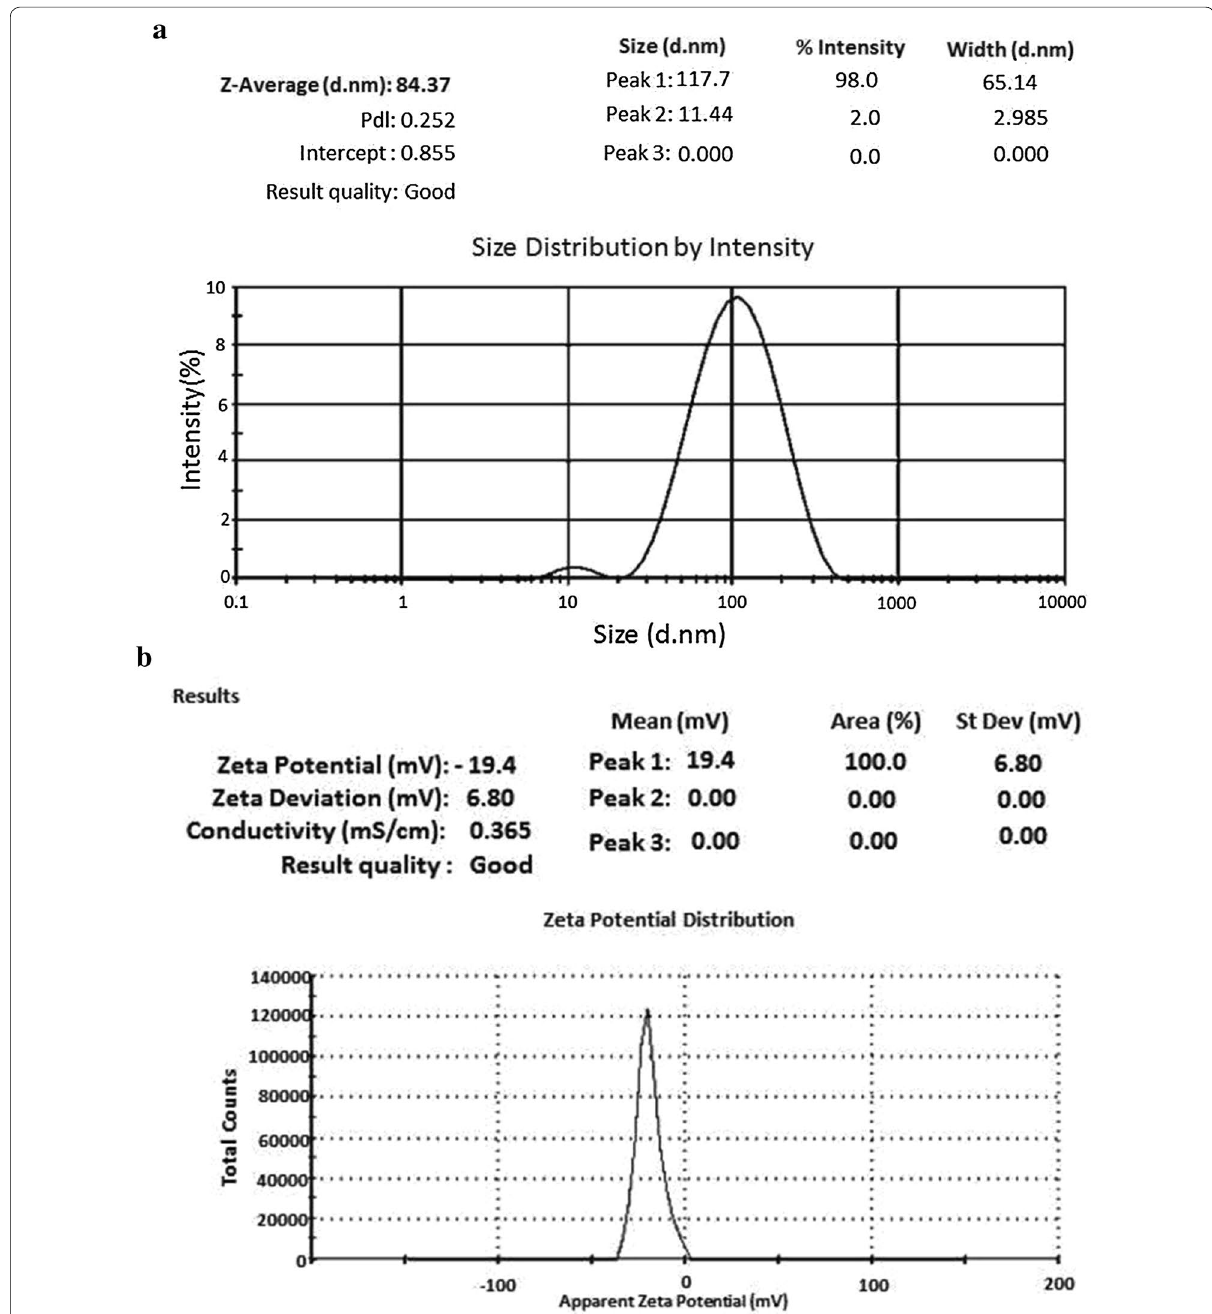
Fig. 3 a DLS size distribution pattern and b Zeta potential analysis of synthesized silver